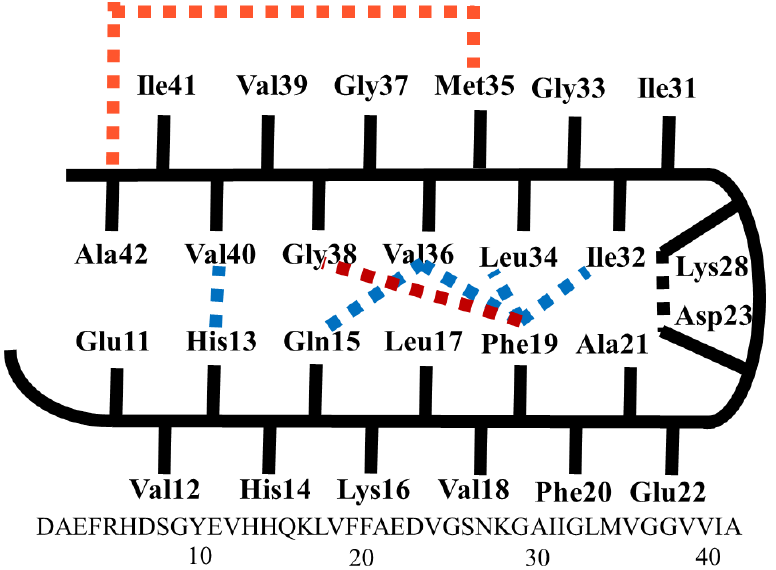
Figure 2. Schematic representation of the monomer structure of A β 40 and A β 42 fibrils.